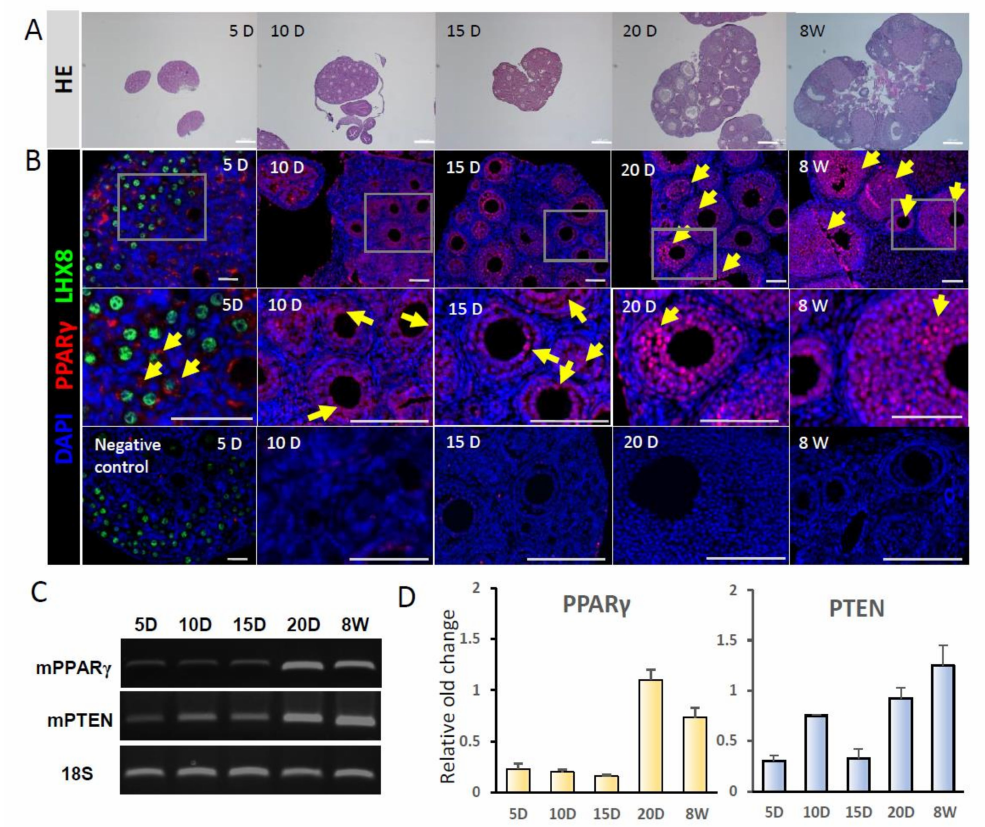
Figure 2. Identification of PPAR γ in mouse ovaries. ( A ) Hematoxylin and eosin (HE) staining. Scale bar = 200 µ m. ( B ) Immunostaining of PPAR γ expression in 5-, 10-, 15-, and 20-day-old, and 8-week-old mouse ovaries. PPAR γ staining is shown in red (yellow arrow); LIM homeobox 8 (LHX8) staining is shown in green. The negative control did not include the primary antibody against PPAR γ . Scale bar = 100 µ m. ( C ) RT-PCR analysis of gene expression. ( D ) Quantitation of results shown in ( C